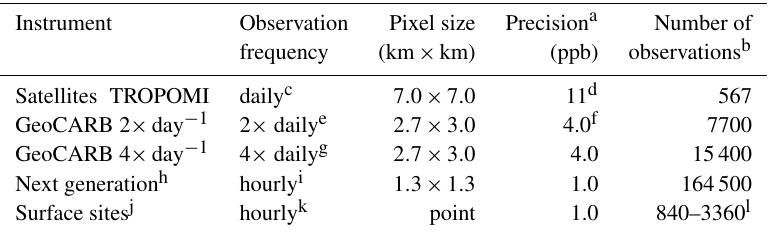
Table 1. Observing configurations considered in this work.